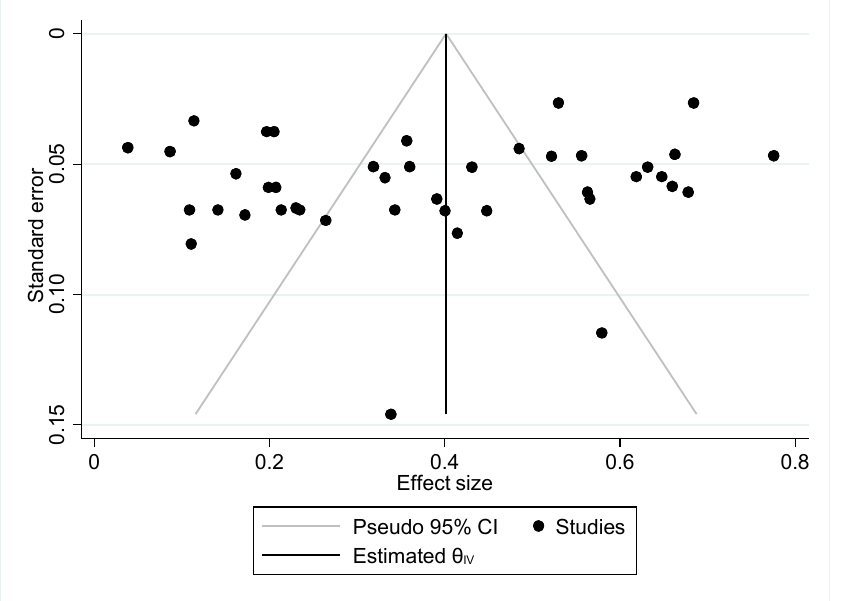
Figure 4. Funnel plot of the 29 articles investigated the association between health concern and consumer purchase behavior.